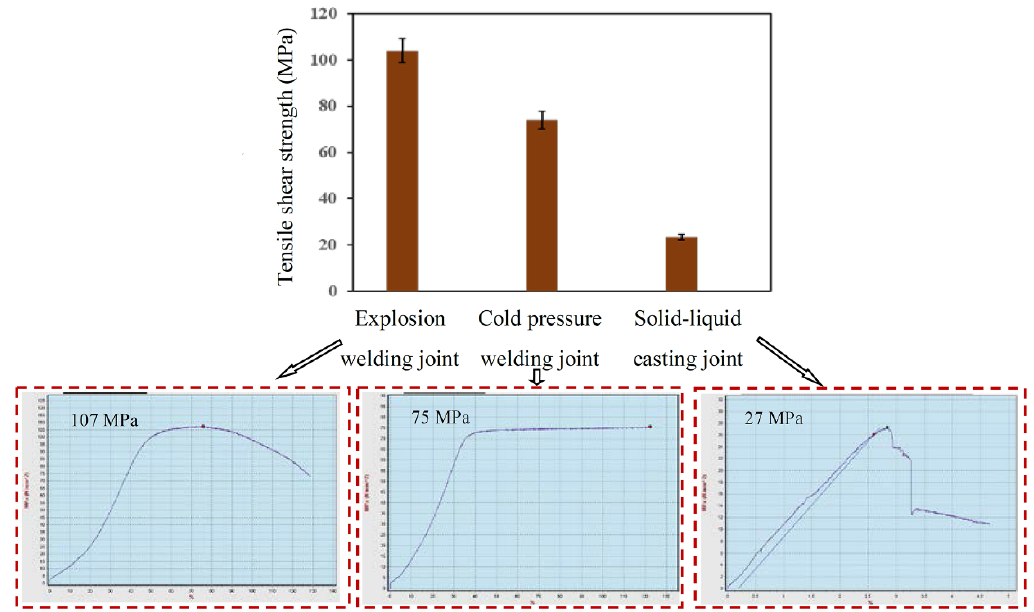
Figure 6. The shear strengths of three kinds of interfaces, and the corresponding stress–strain curve.